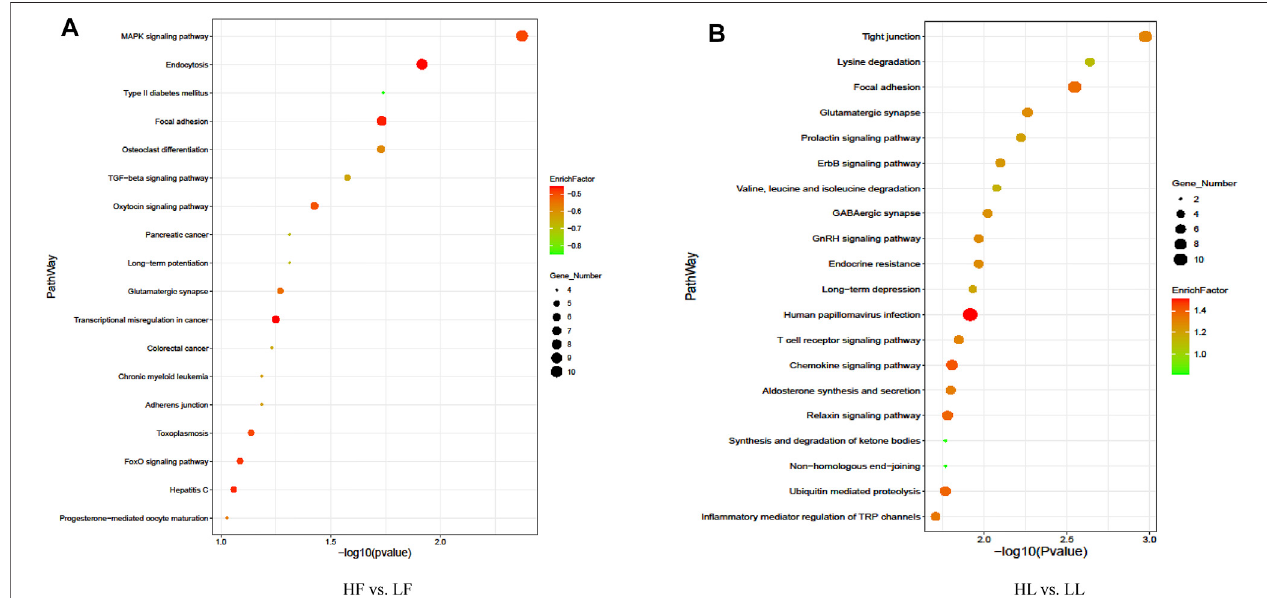
FIGURE 6 | Kyoto Encyclopedia of Genes and Genomes pathway enrichment analysis. (A) The pathways enriched in high-yielding goats in the follicular phase versus low-yielding goats in the follicular phase (HF vs. LF). (B) The pathways enriched in high-yielding goats in the luteal phase versus low-yielding goats in the luteal phase (HL vs. LL). Note. p <